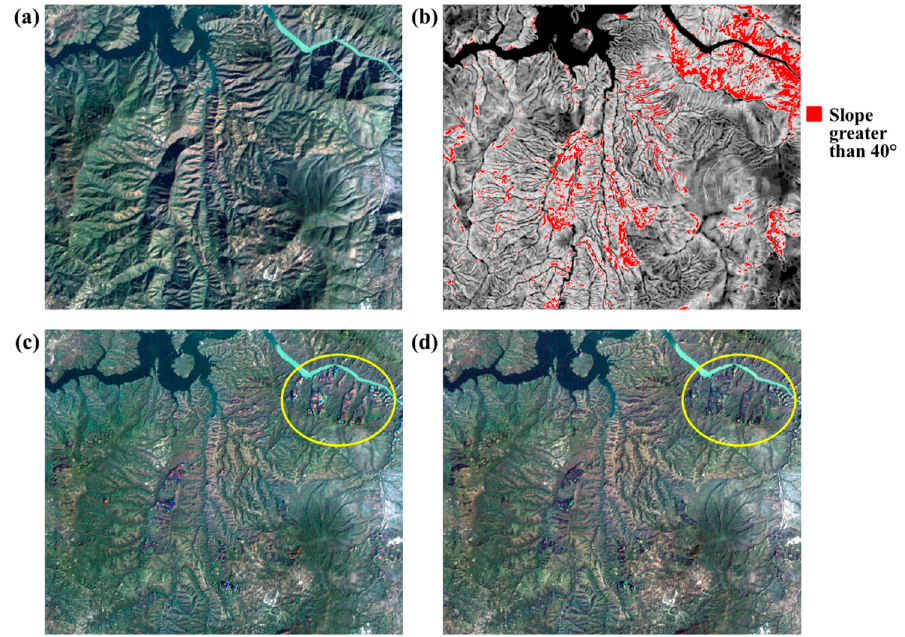
Figure 4. Resulting images of topographic correction by the SCS + C method. ( a ) Color composition (CC) 321, before topographic correction; ( b ) Slope spatial distribution; ( c ) CC-321 result of the correction by N-SC; ( d ) CC-321 result of the correction by SC. Image: Landsat TM from 27 November 1995.